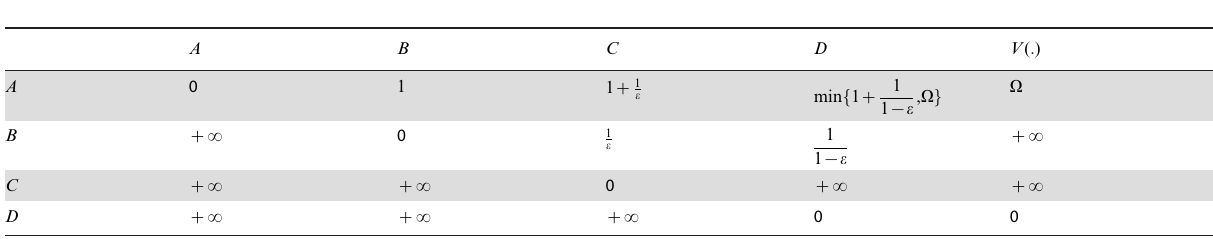
Table 2. Quasi-distances and Value function for example